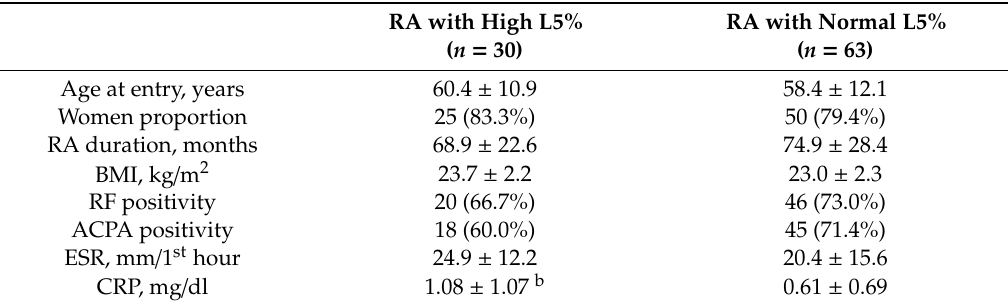
Table 1. Demographic and laboratory data in rheumatoid arthritis (RA) patients with high percentage of L5 in low-density lipoprotein (LDL) (L5%) and with normal L5%